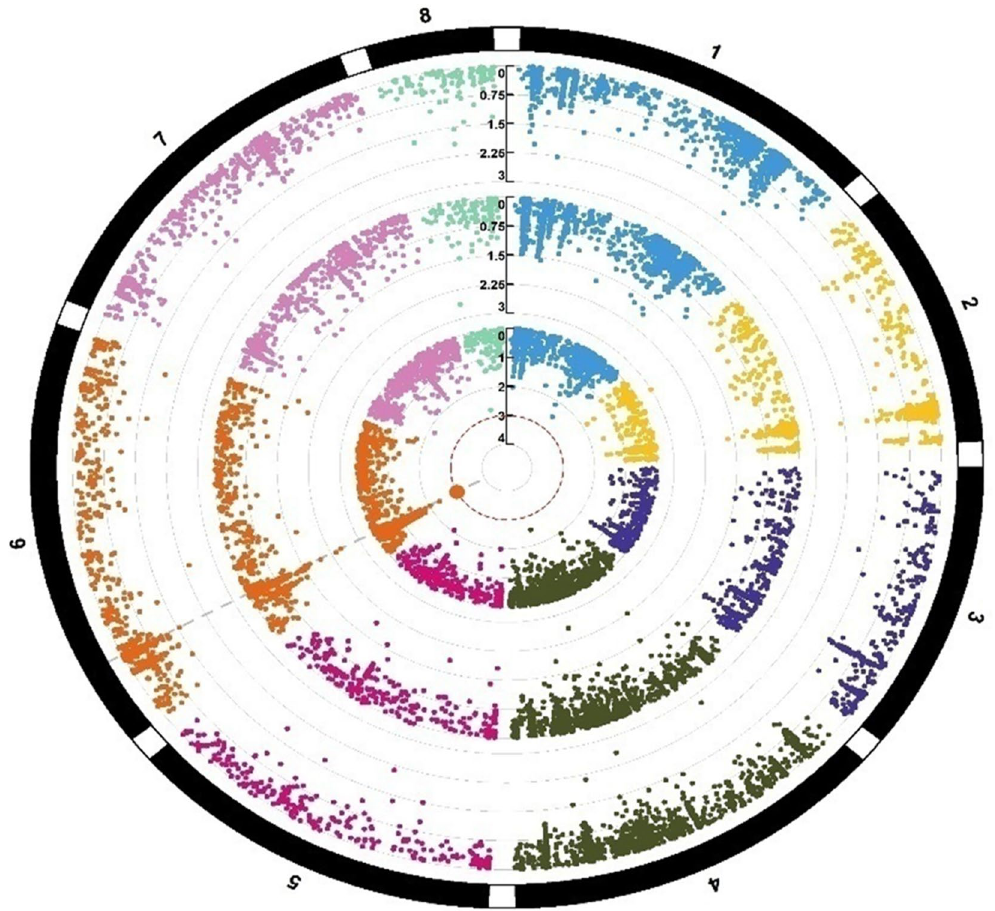
Figure 5. Circular Manhattan plots of showing marker-trait associations (MTAs) for seed Fe concentrations. The eight different colors represent 8 different chickpea chromosomes. The three concentric circles (each having 8 colors) shows MTAs identified for seed Fe concentrations in two environments and data pooled over